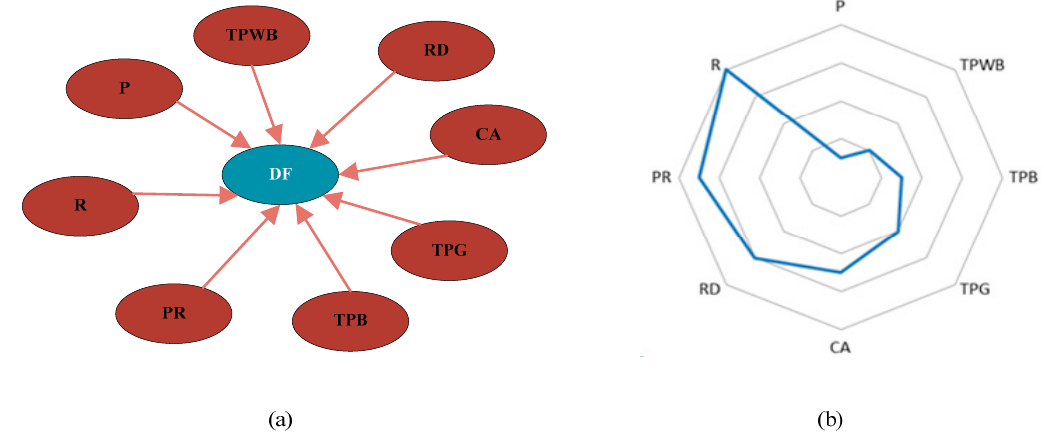
Figure 3. Network diagram of dependencies: ( a ) Through training the NB model with training data, the top eight factors influencing the depth of urban flood were extracted from 11 predictive factors; ( b ) The radar map is used to display the ranking results of these eight factors. It can be seen that the contribution of rainfall to the formed flood depth is the largest and the proportion of water bodies is the smallest in the top eight factors.